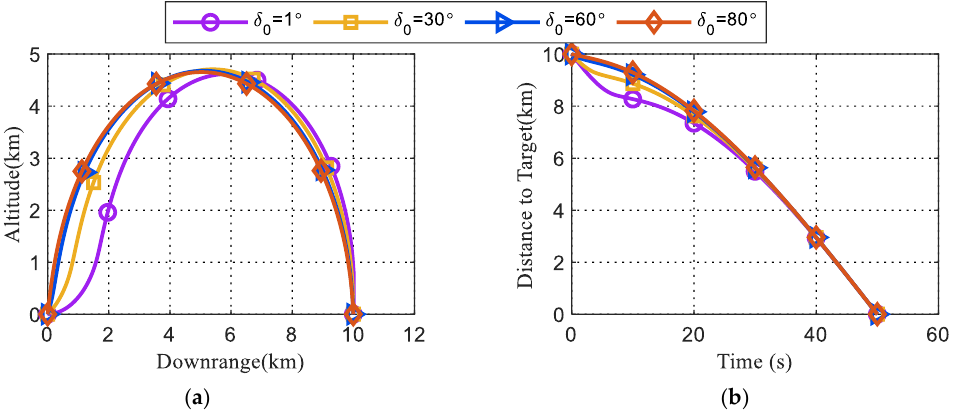
 = 80°. ( a ) Trajectories; ( b ) Distance